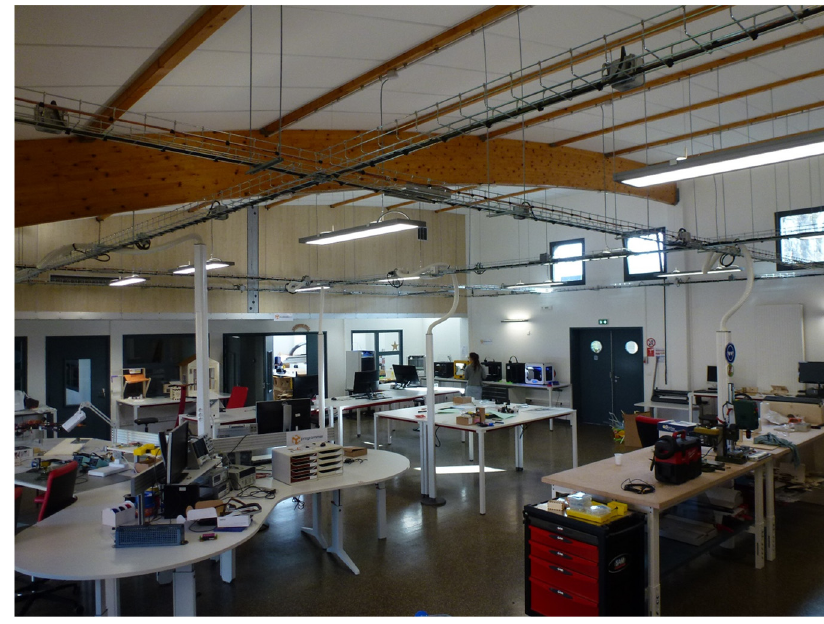
Figure 1. FabLab “Make” at Centrale Lille Institut.